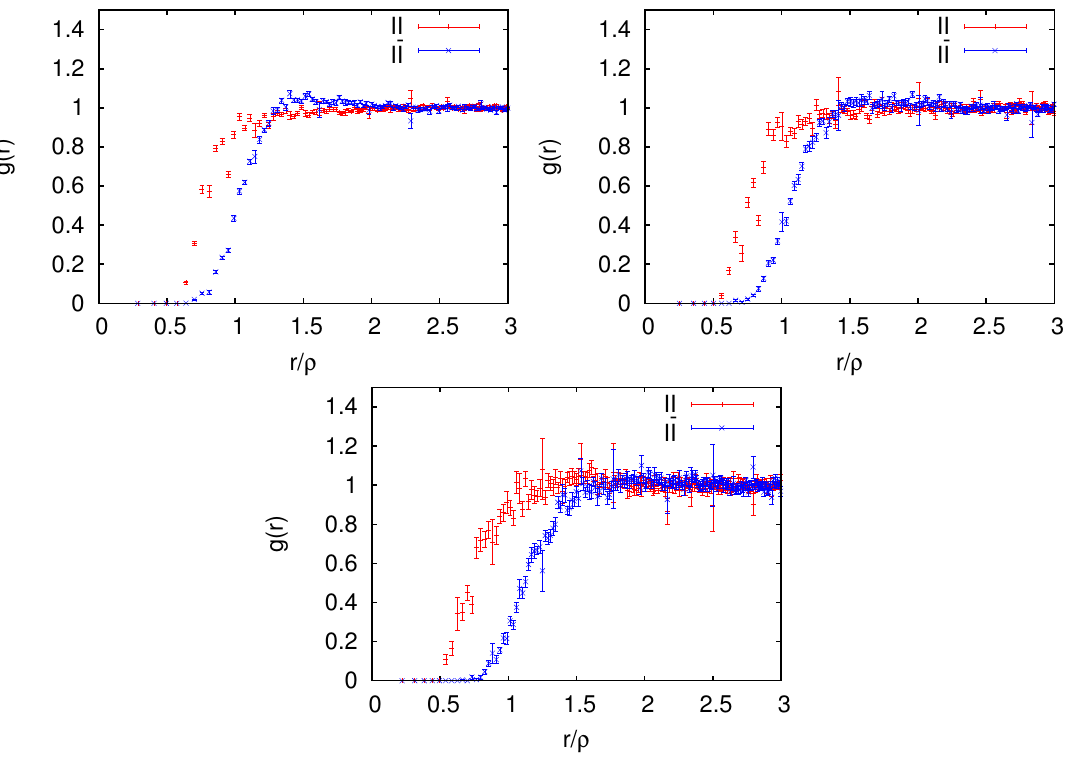
Figure 3 . (Color online) Pair correlation function for II and AA pairs (red) and for IA pairs (blue) for (cid:12) = 4 : 2, V = 32 4 and a Wilson (cid:13)ow time of (cid:28) = 4 (leftmost upper), 8 (rightmost upper) and 15 (lower). The distribution is characteristic of a gas, with an excluded volume that is larger for IA pairs than for II or AA